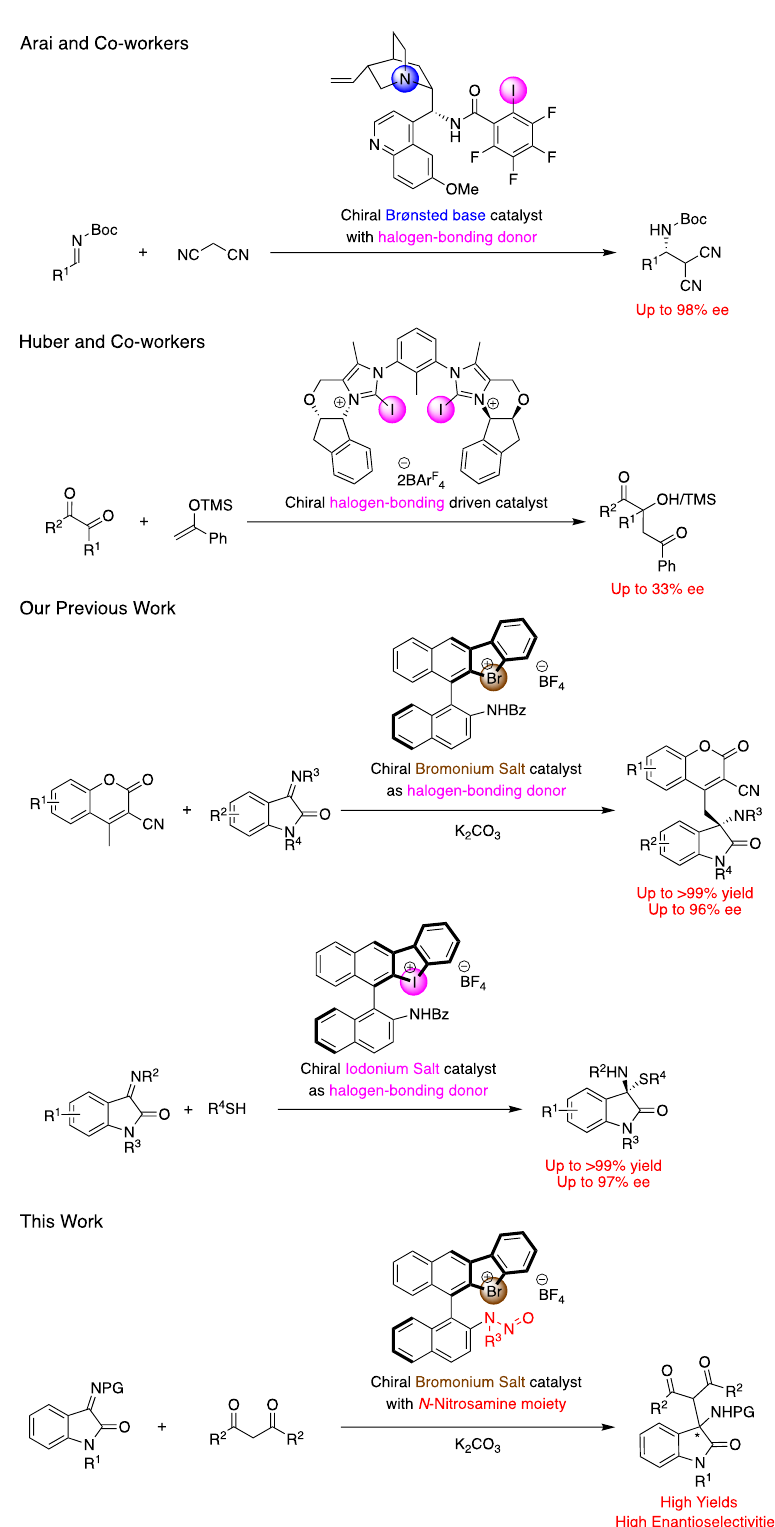
Figure 1. Examples of chiral halogen-bonding catalysts. Hypervalent halogen reagents, especially hypervalent iodine reagent, have been researched as highly reactive chemical species which act as substrates and as catalysts in oxidation reactions [25–31]. Although the iodonium and bromonium salts, which are kinds of hypervalent halogen compounds, have been found to work as XB catalysts